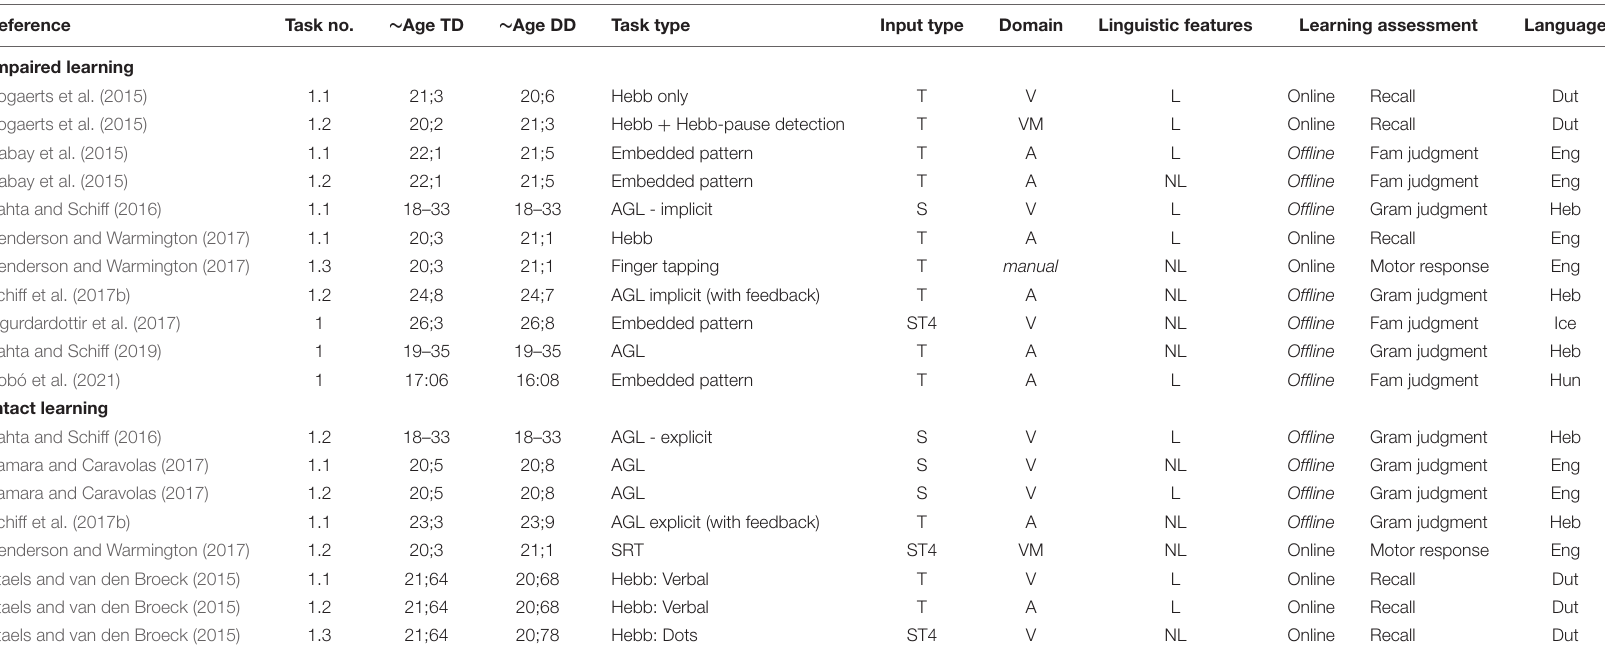
TABLE 2 | Table of studies with adult participants; studies with more than one task are indicated by task number; tasks showing instances of impaired learning (top) are followed by ones showing intact learning (bottom). Reference